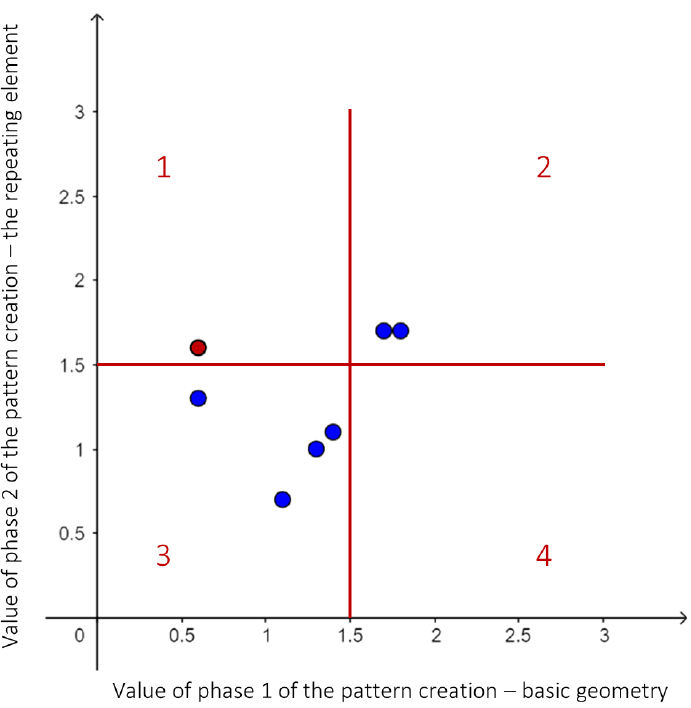
Figure 16. Split chart—x and y coordinates of the first